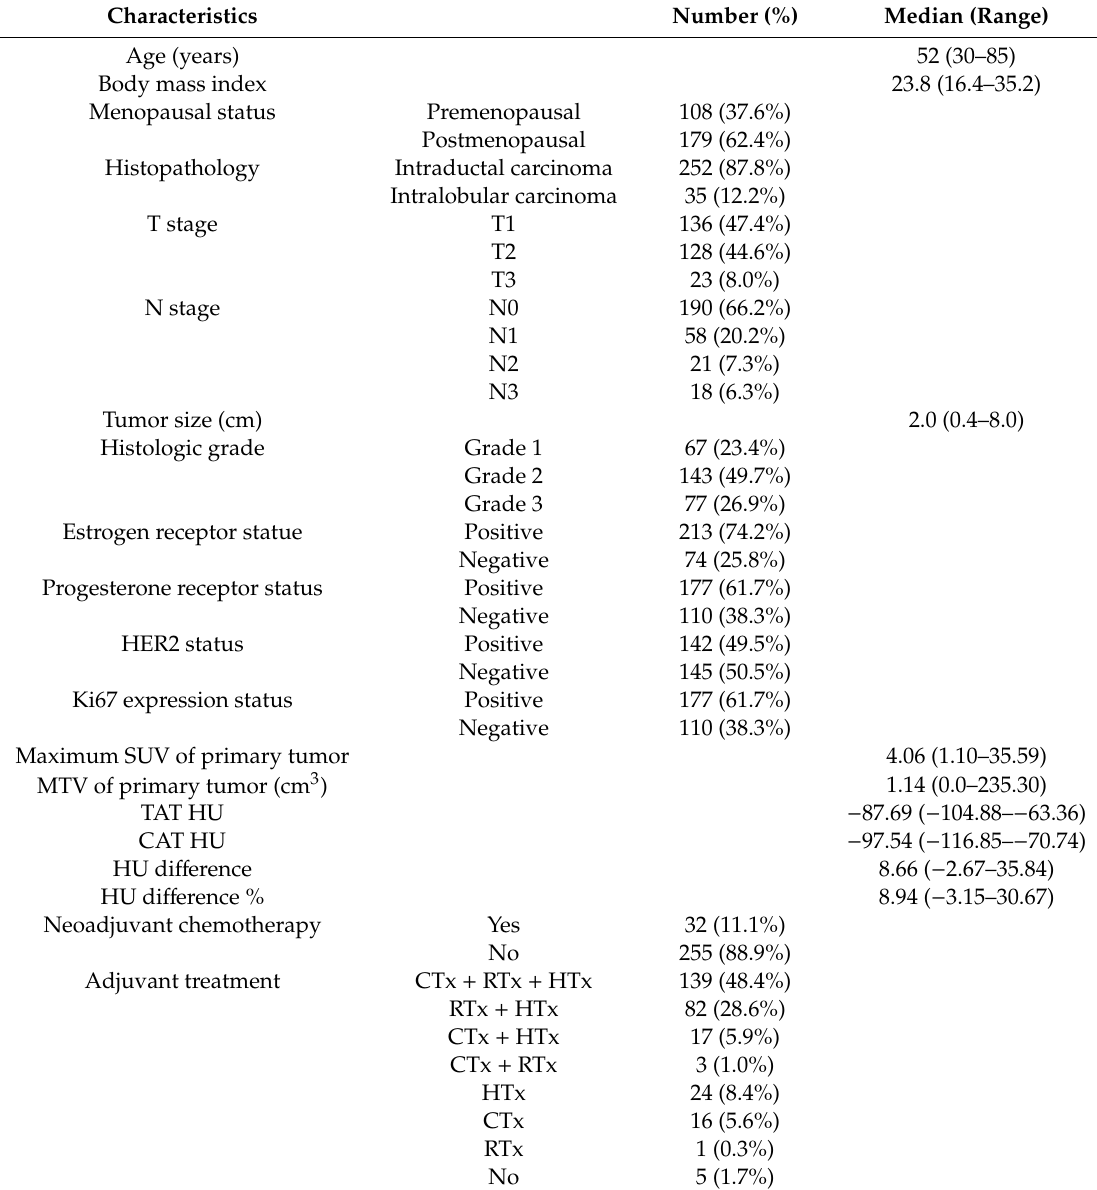
Table 1. Baseline characteristics of patients ( n =